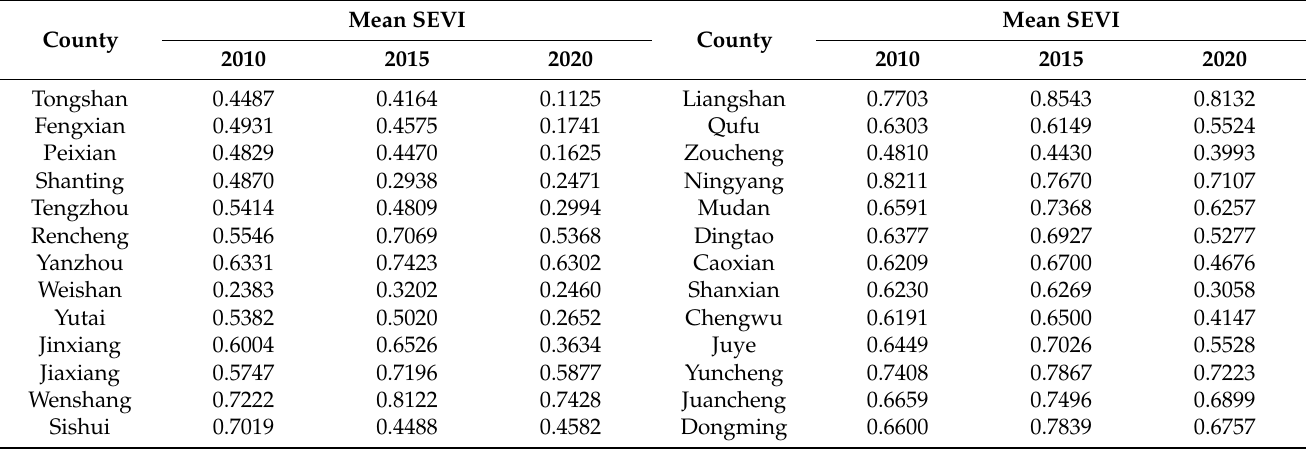
Table 6. Mean standardized ecological vulnerability index in different administrative regions.